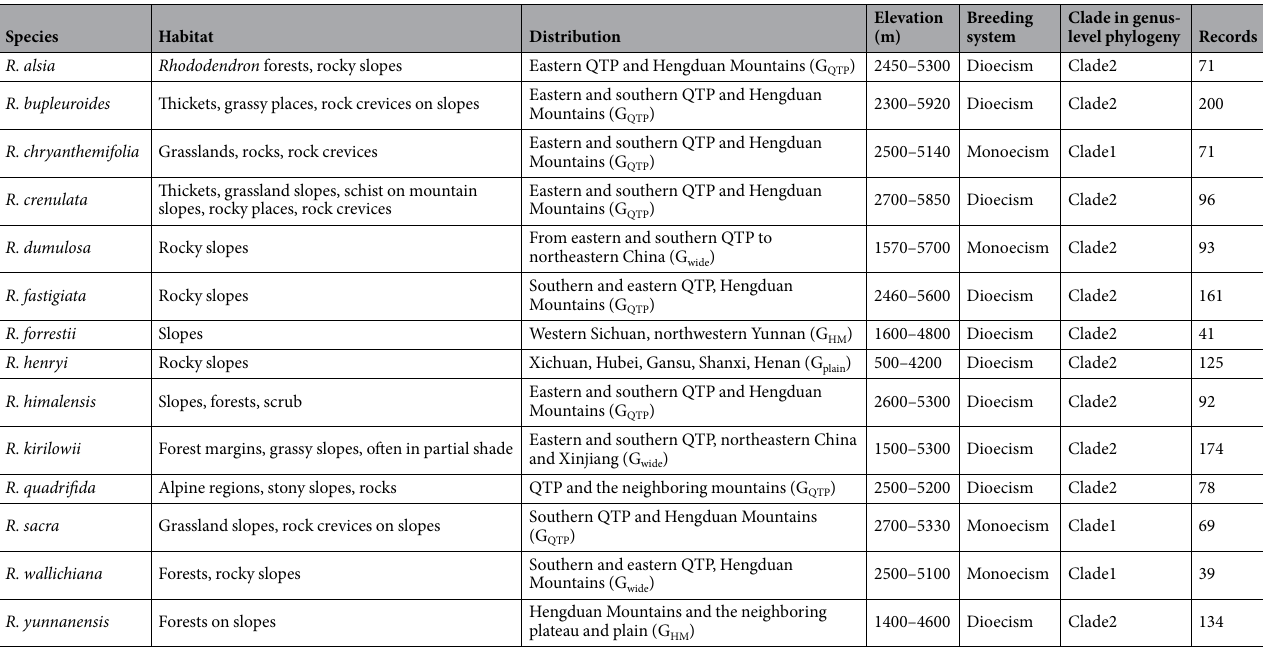
Table 1. Ecological information for the 14 Rhodiola species 14 and occurrence data used for